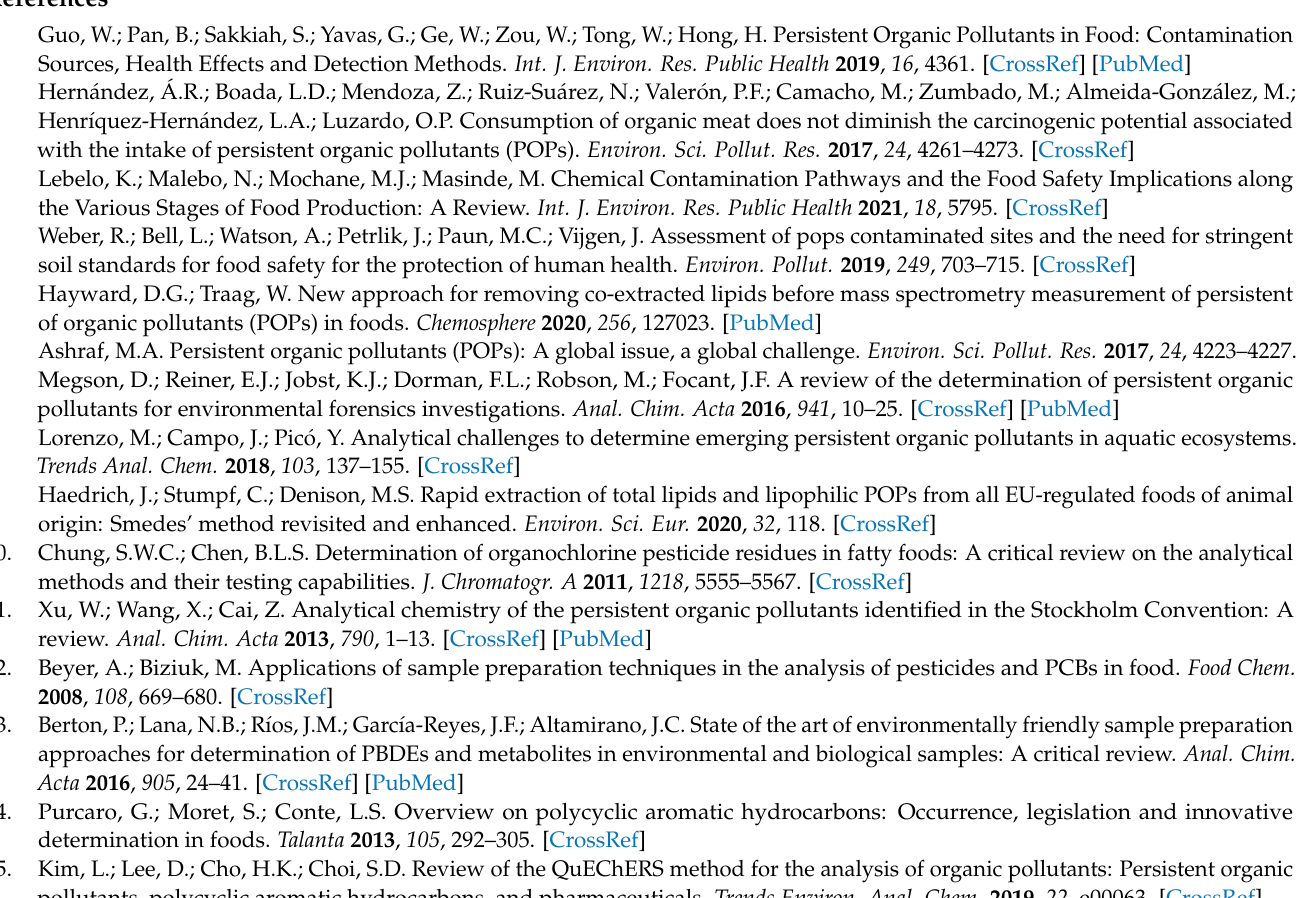
Supplementary Materials: The following are available online at https://www.mdpi.com/article/10 .3390/toxics10010012/s1. Table S1: MRM transitions. Table S2: Method performance characteristic Figure S1: The comparison of fatty acids removal (scanned mass range m/z 100–500) between crude and purified extracts of the smoked trout using different sorbents detected by DART(-)-HRMS. Figure S2: GC-MS/MS MRM chromatograms of target OCPs, PCBs and PBDEs in spiked smoked trout (concentration level: PAHs, OCPs = 2 µ g · kg − 1 ; PCBs, PBDEs = 5 µ g · kg − 1 , MRM transitions are shown in Table S1). Figure S3: LC-MS/MS MRM chromatograms of smoked trout spiked with (A) HBCDs, TBBPA and (B) PFAS (concentration level: PFAS–0.25 µ g · kg − 1 and HBCD and TBBPA = 2.5 µ g · kg − 1 , MRM transitions are shown in Table